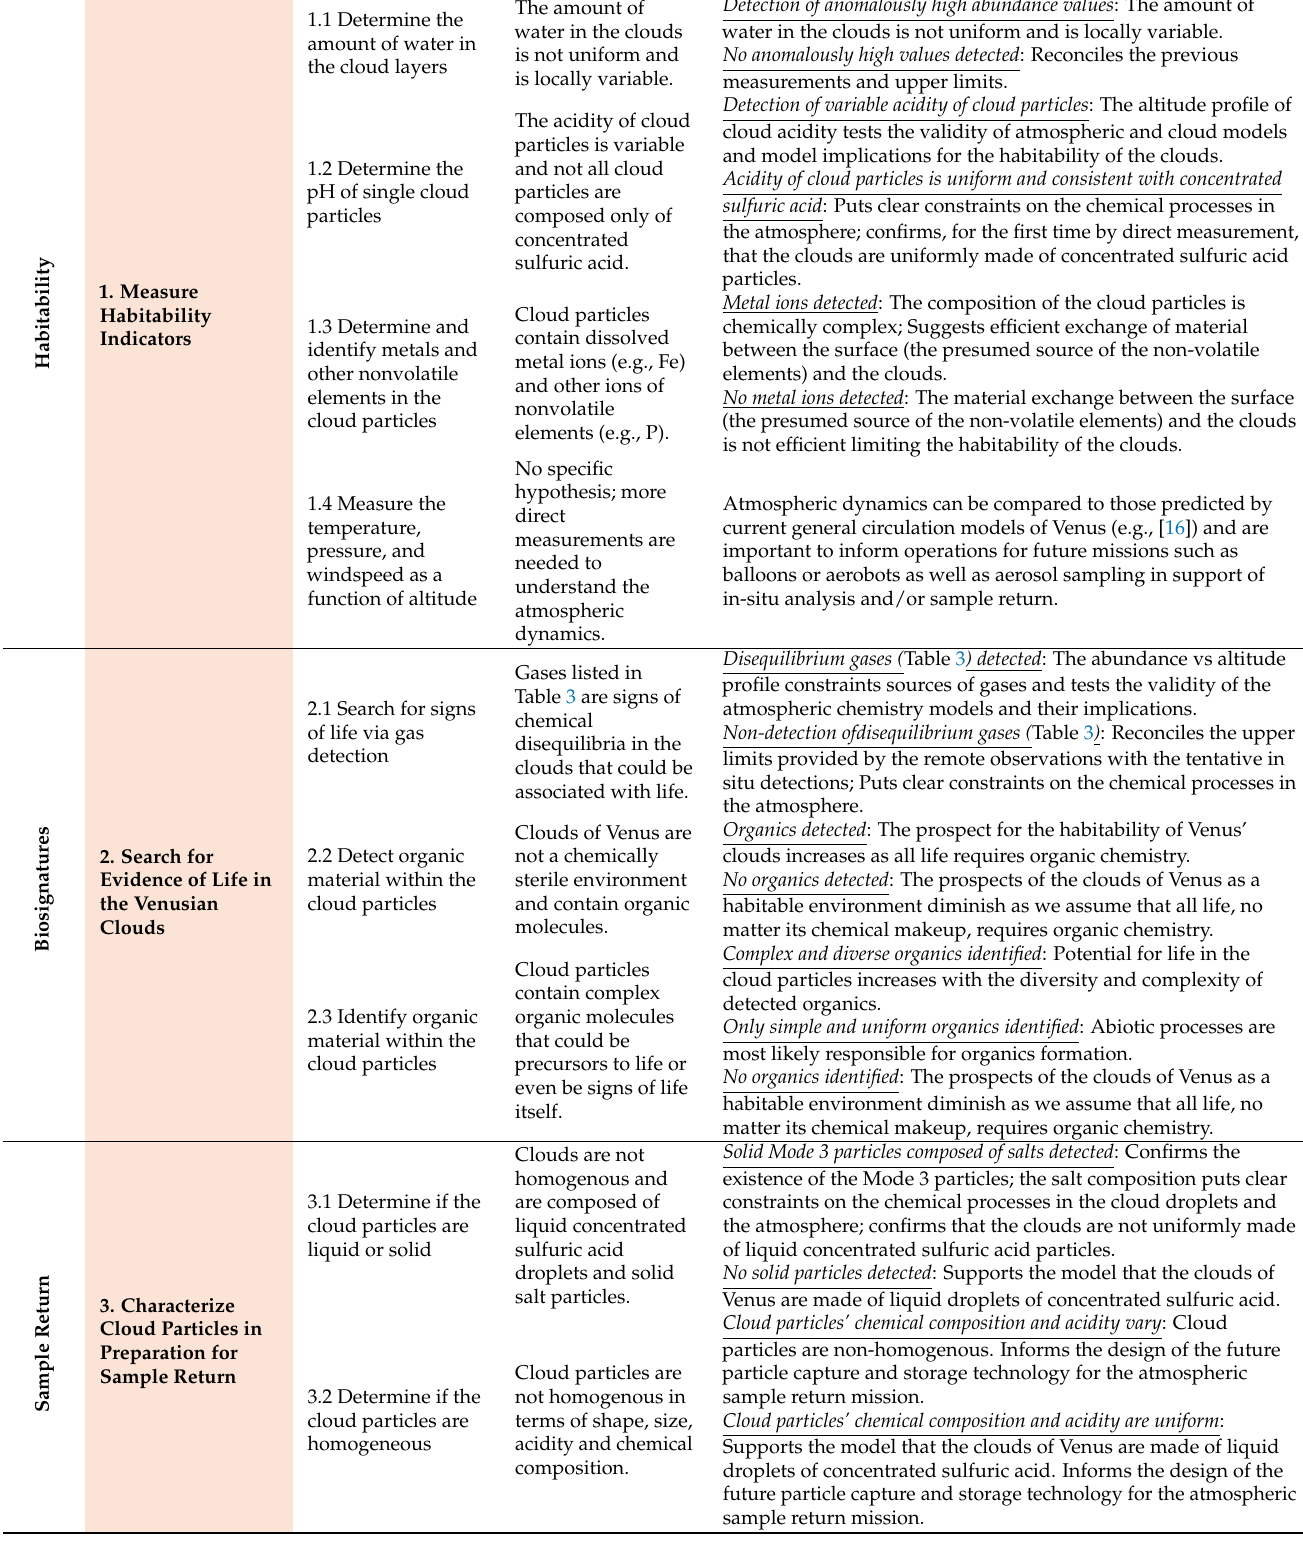
Table 2. Venus Habitability Mission science